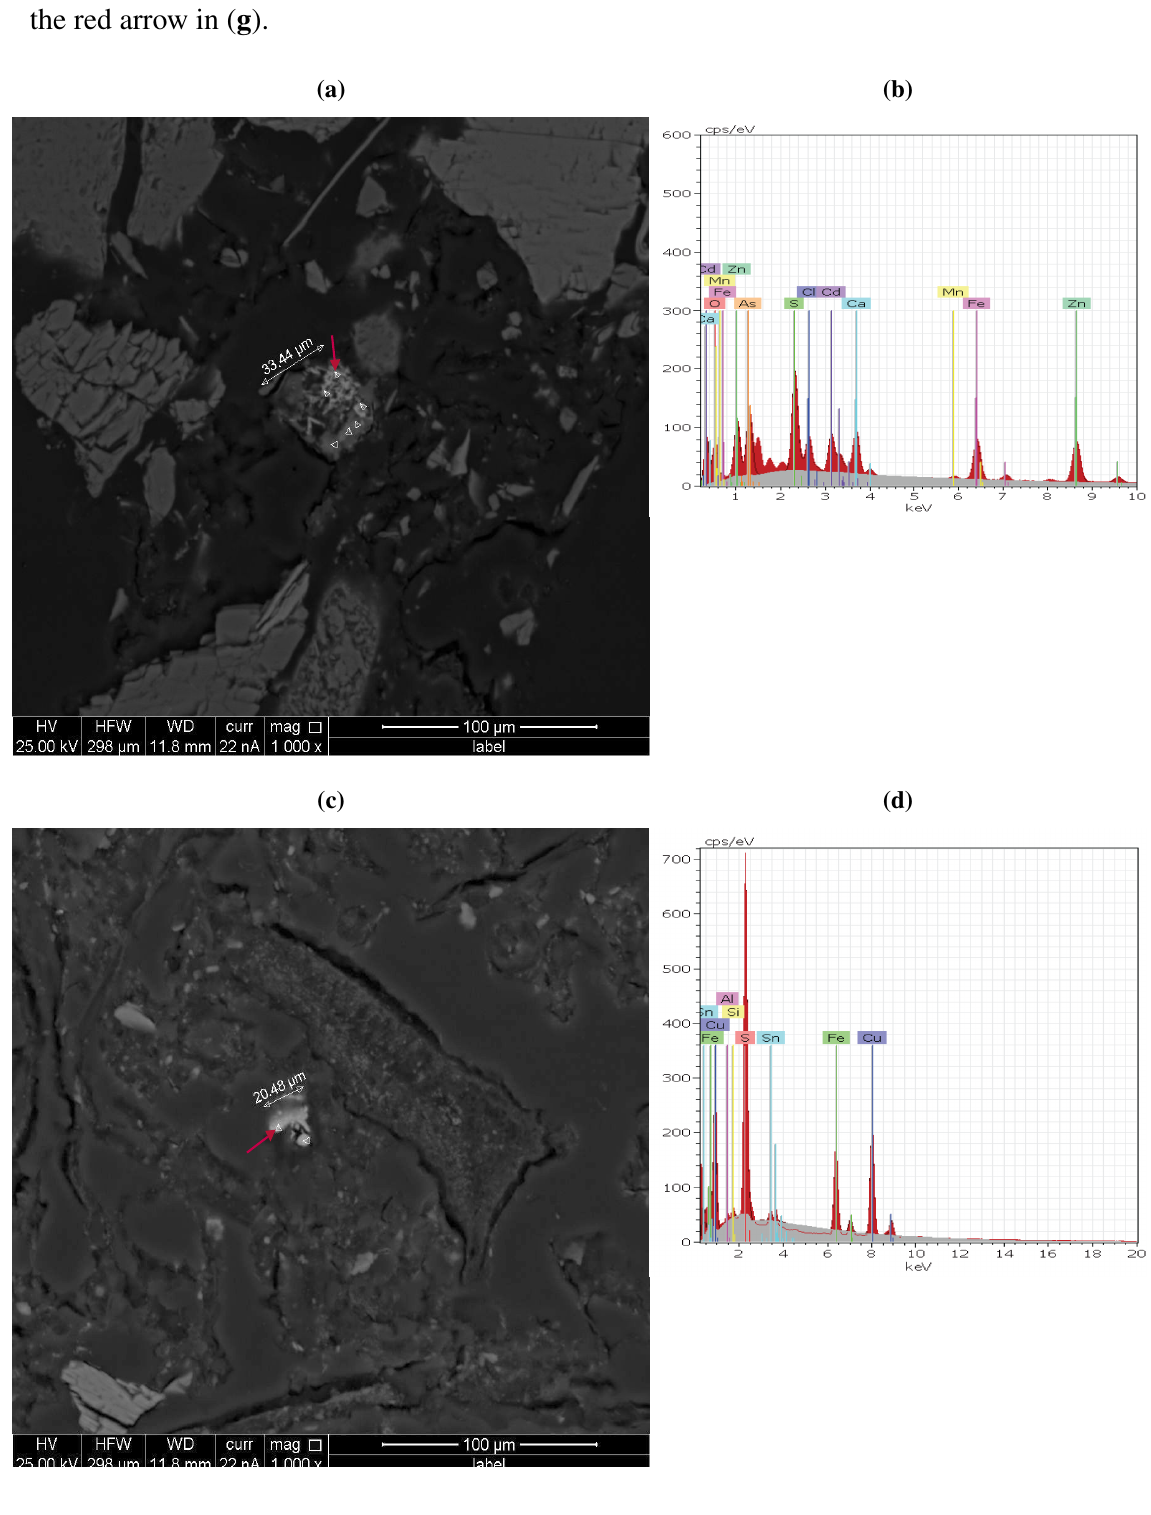
Figure 3. Backscattered electron microscopy photomicrographs and EDX spectra of some other mineral particles: ( a ) arsenic-zinc-iron- ± cadmium-bearing particles; ( b ) EDX spectra for the point indicated by the red arrow in ( a ); ( c ) copper-iron-sulphide particles; ( d ) EDX spectra for the position indicated by the red arrow in ( c ); ( e ) zinc-phosphorus, metallic zinc and zinc-iron-sulphide particles; ( f ) EDX spectra for position indicated by the red arrow in ( e ); ( g ) arsenic-iron-zinc-oxide particle and ( h ) EDX spectra for the position indicated by the red arrow in ( g